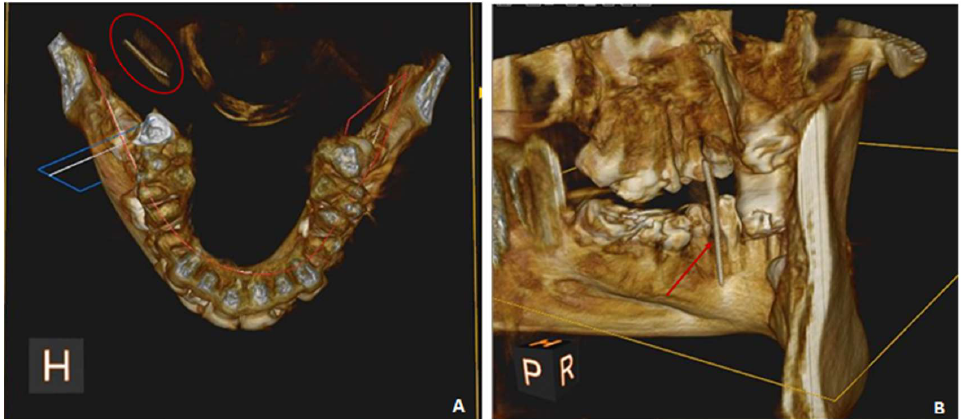
Figure 4. ( A ) Reproduction of a three-dimensional image of the facial bone showing the fractured needle (red circle); ( B ) other projection of a three-dimensional image of the facial bone showing the fractured needle (red arrow).